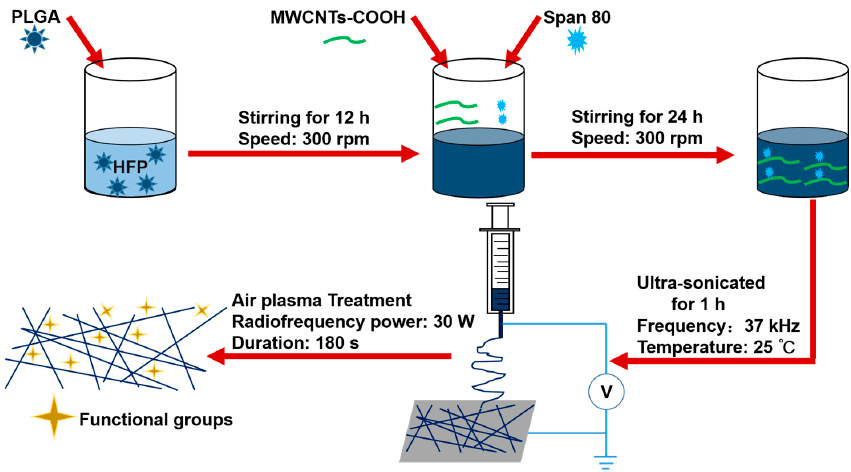
Figure 1. Schematic illustration of solution preparation, electrospinning and air plasma treatment.